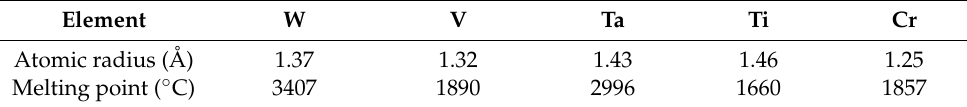
Table 1. Basic properties of elements in WVTaTiCr x RHEA coating [34].